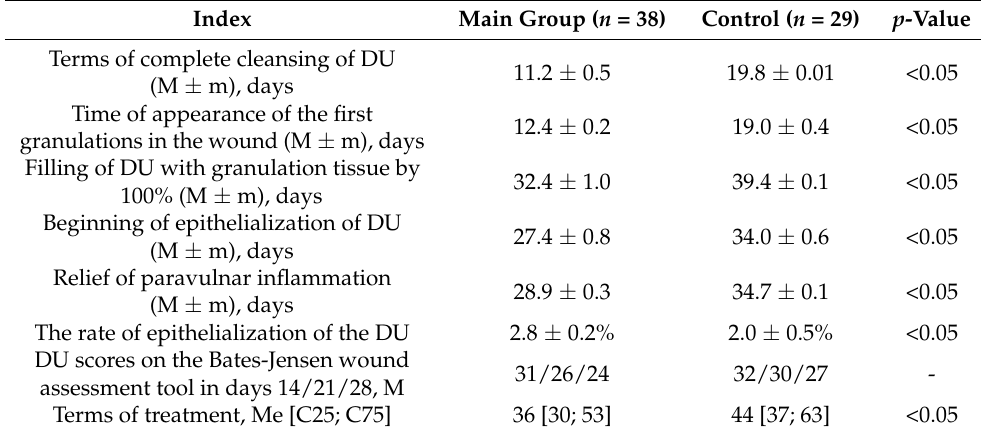
Table 1. Parameters of the wound process in clinical groups.